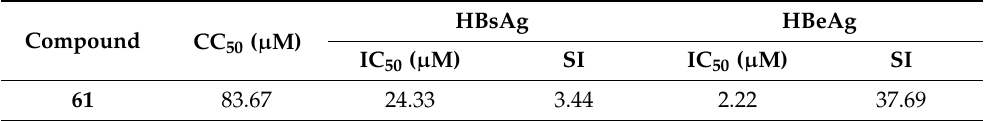
Table 8. The SAR study of compound 61 against HBV.